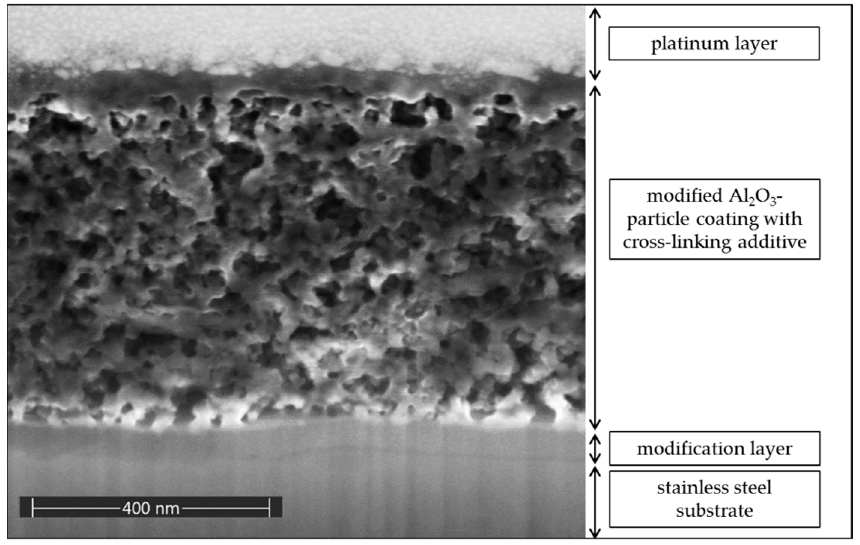
Figure 3. Cross-section of a coating on modified stainless-steel substrate.